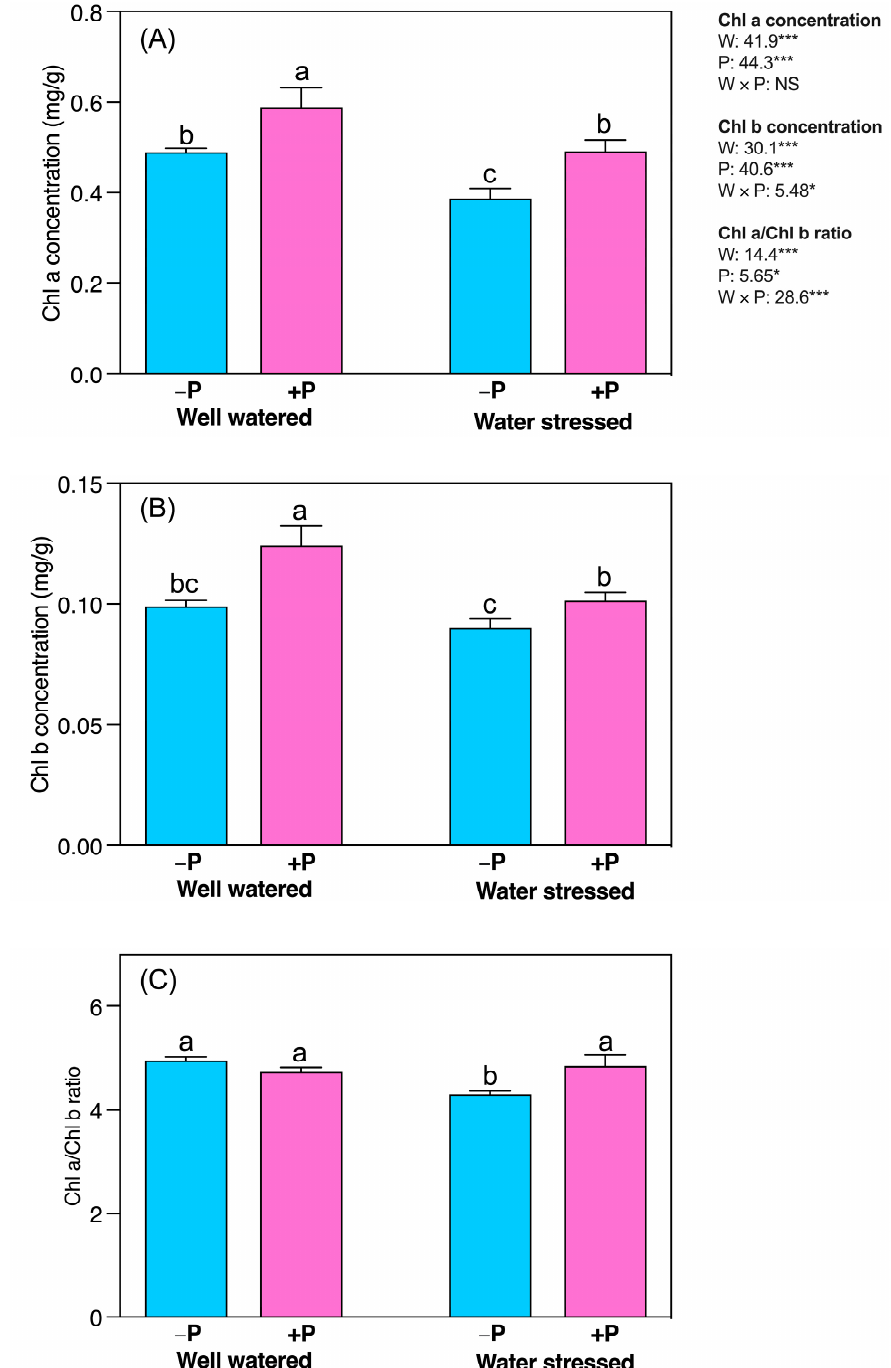
Figure 2. Changes in concentrations of ( A ) chlorophyll a , ( B ) chlorophyll b and ( C ) chlorophyll a / b ratio in response to P supplementation, under well-watered and drought-stressed conditions. A different letter following the means indicates significant differences ( p < 0.05) between the four treatments, as determined by Duncan’s test. Bars represent means ± SD. An overview of the two-way ANOVA assessing the effect of water (W) and phosphorus (P) treatments is presented in the right-hand corner of each panel. * and *** indicate that F values were significant at p ≤ 0.05, 0.01, and 0.001, respectively.